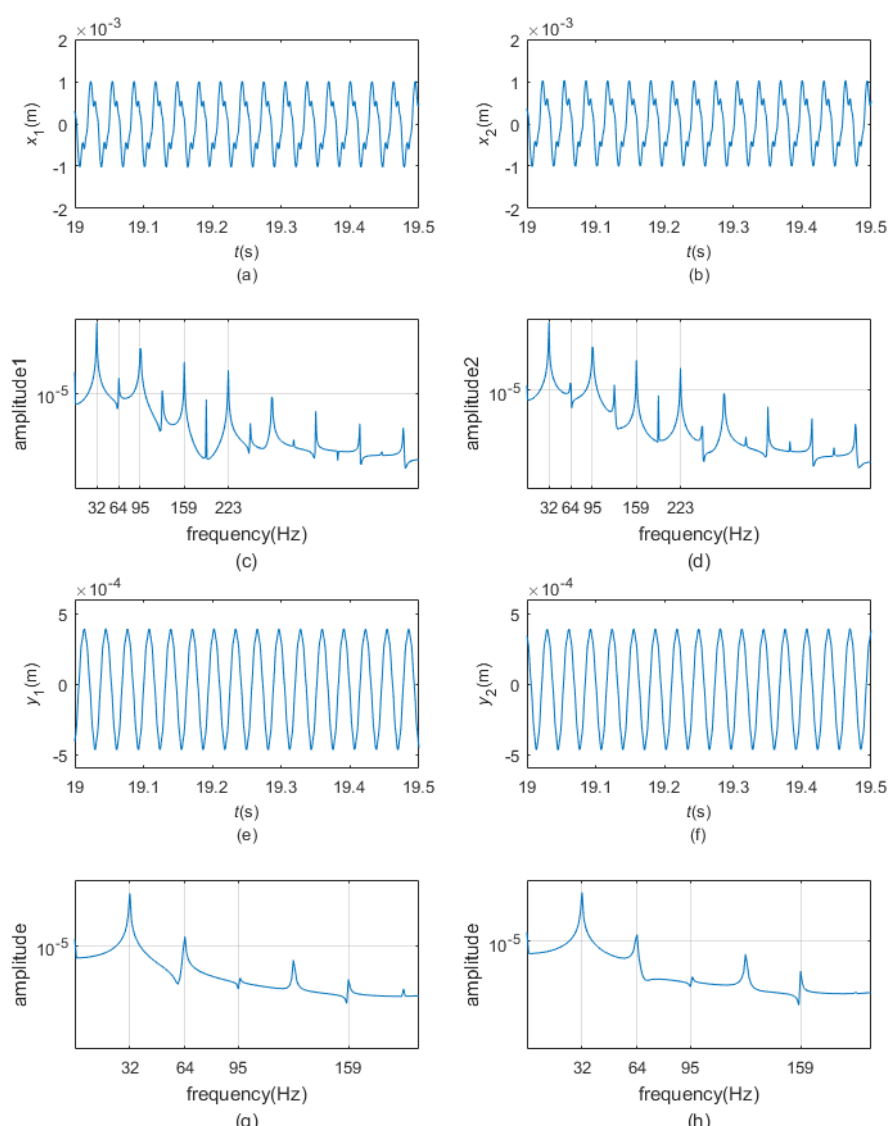
Figure 14. The motion and frequency spectrums of the dampers in the x direction ( a, b, c, d ); the motion and frequency spectrums of the dampers in the y direction ( e, f, g, h ).